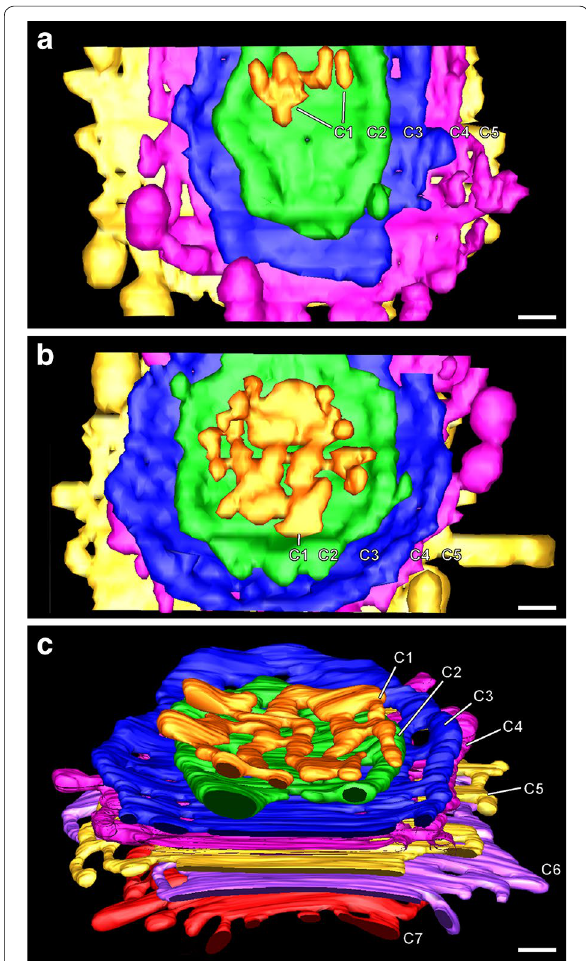
Fig. 9 Tomographic models illustrating the variability in size and geometry of C1 cis -Golgi cisterna initials. The cisternae are color coded: C1 (orange), C2 (green), C3 (blue), C4 (pink), C5 (yellow), C6 (purple), C7 (red). The smallest C1 cisterna initial seen in a has a surface area equivalent to 3–4 COPII vesicles. The larger cisterna initials ( a – c ) possess branched, tubular architectures with many tubules exhibiting COPII vesicle-size spherical ends. The Golgi stacks depicted in a and b are shown in face-on views, and in c the stack is presented at an angle to highlight both the geometry of the C1 cisterna and the spatial organization of the stack. Bars 0.1